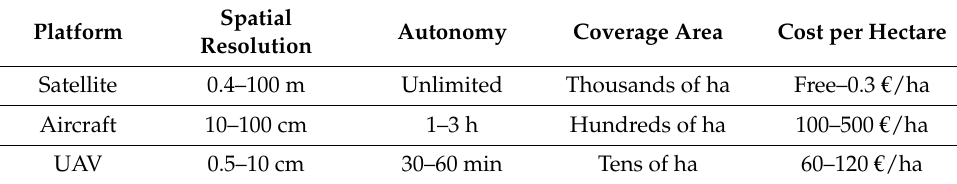
Table 3. Remote sensing platforms comparison